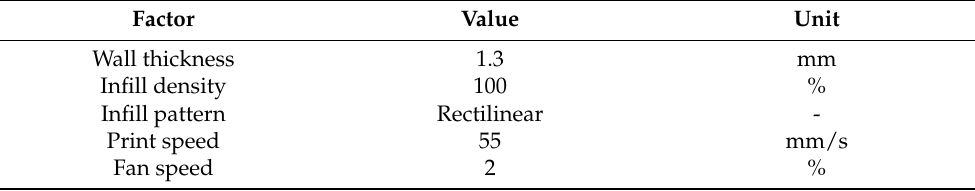
Table 4. Default Printing factors .